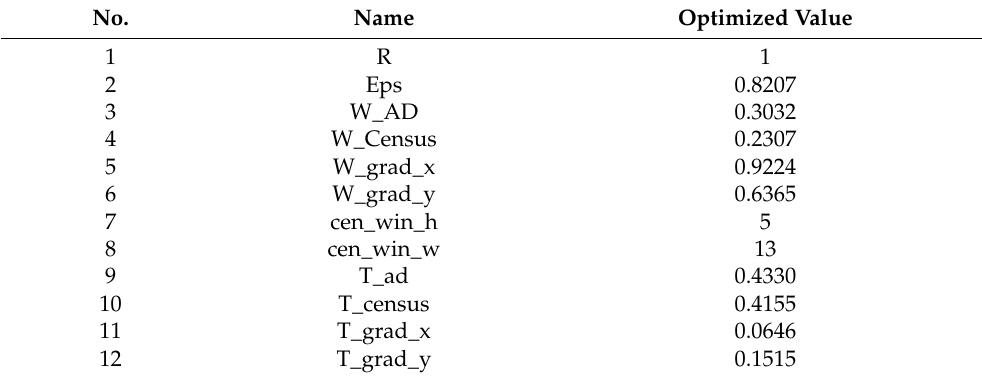
Table 3. The specific value of each parameter in STMCF.